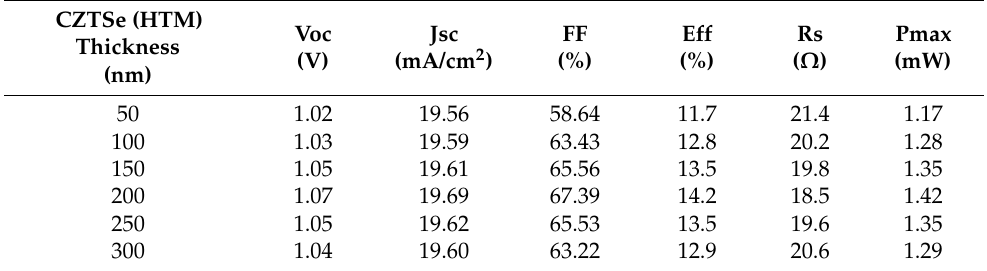
Table 2. Photovoltaic characteristics of the Ag/C 60 /MAPbI 3 /CZTSe/Mo/FTO solar cells with various CZTSe film thicknesses, all thermally annealed at 500 ◦ C. CZTSe